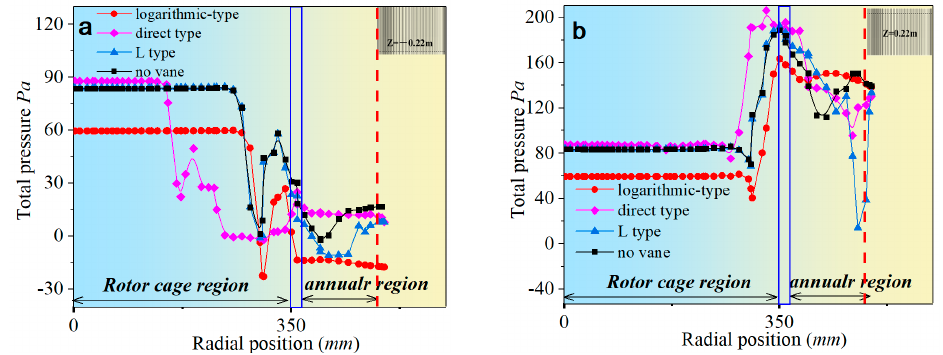
Figure 13. Comparison of the total pressure of rotor cage by four different guide vanes in two sections ( a ) Z = − 0.22 m, ( b ) Z = 0.22 m.